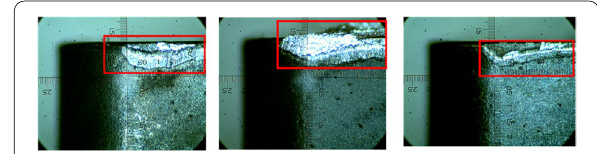
Figure 1 Degradation of cutting tools